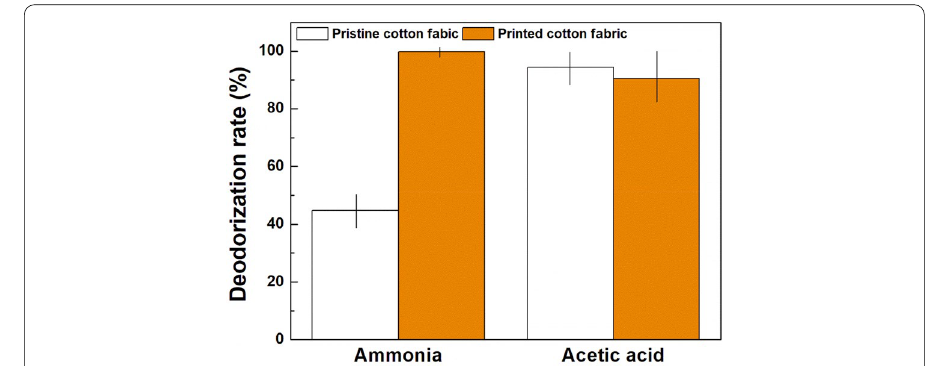
Fig. 7 Deodorization rate of pristine and gallotannin-printed cotton fabrics